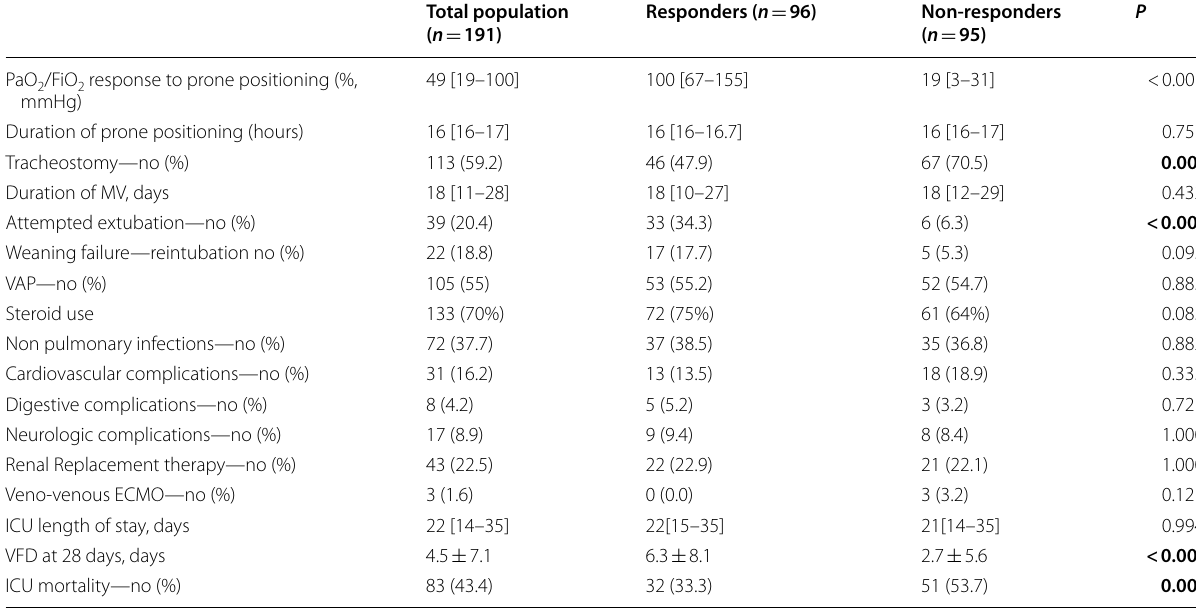
Values are median (IQR) except for VFD (Mean